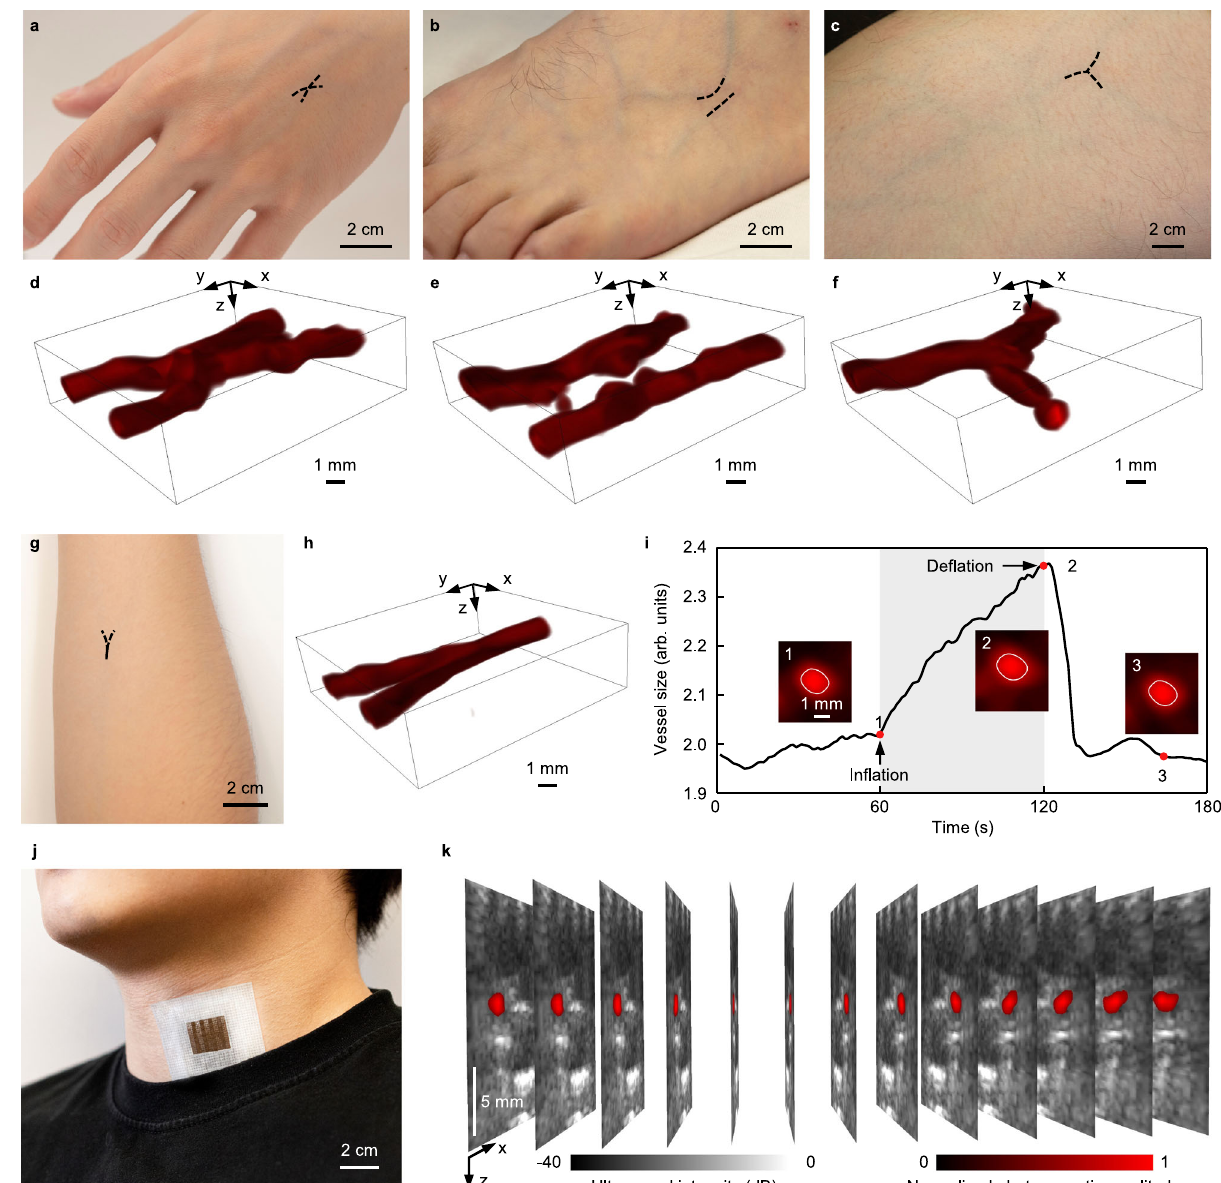
Fig. 4 | In-vivo imaging of blood vessels and venous occlusion test. a – h Photos of the hand, foot, thigh and forearm where the target veins are highlighted. The reconstructed3Dphotoacousticimagesareallshownaccordingly. i Crosssectional sizechangesoftheveinbeforecuffin fl ation,duringcuffin fl ationwithapressureof 70mmHg,andcuffde fl ation.Thepixelsinsidethewhiteboundarywithavalue>0.5